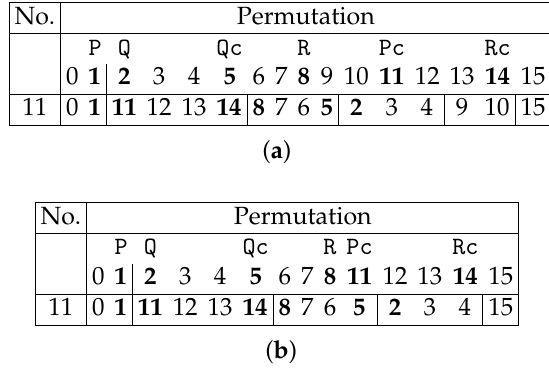
Table 7. Example of a 5-opt operations that can collapse to 4-opt operation: ( a ) all 16 points exist; ( b ) points 9 and 10 do not exist.